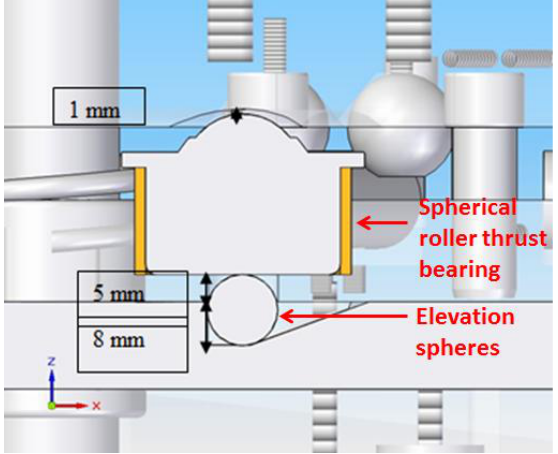
Figure 7. Detail view of steel bar, elevation spheres and spherical roller thrust